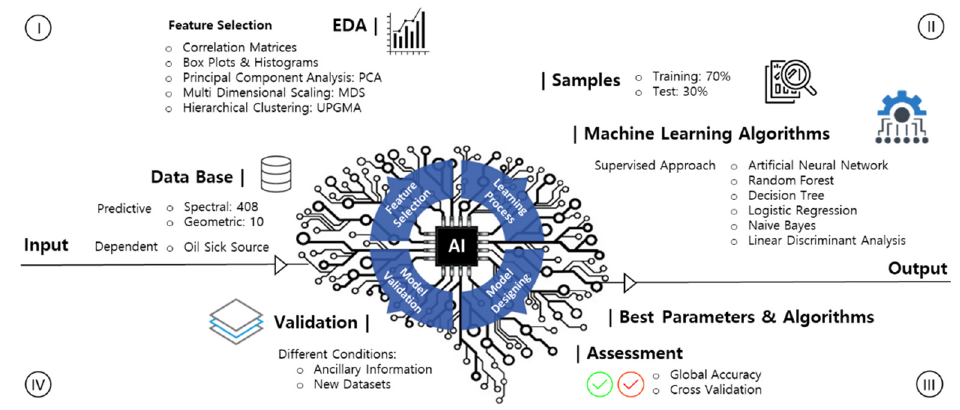
Figure 3. Workflow employed to develop the classification models for OSS identification.